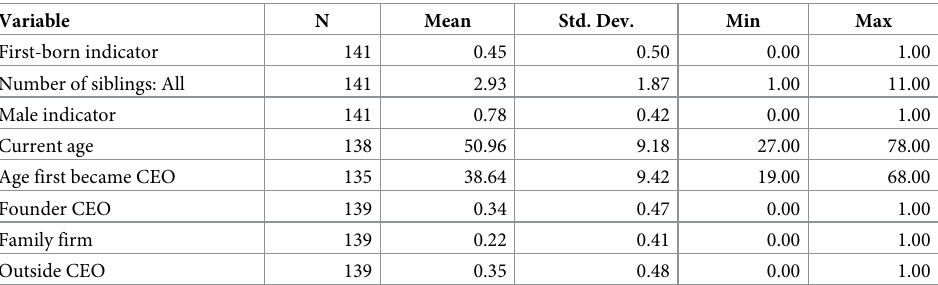
Table 1. Summary